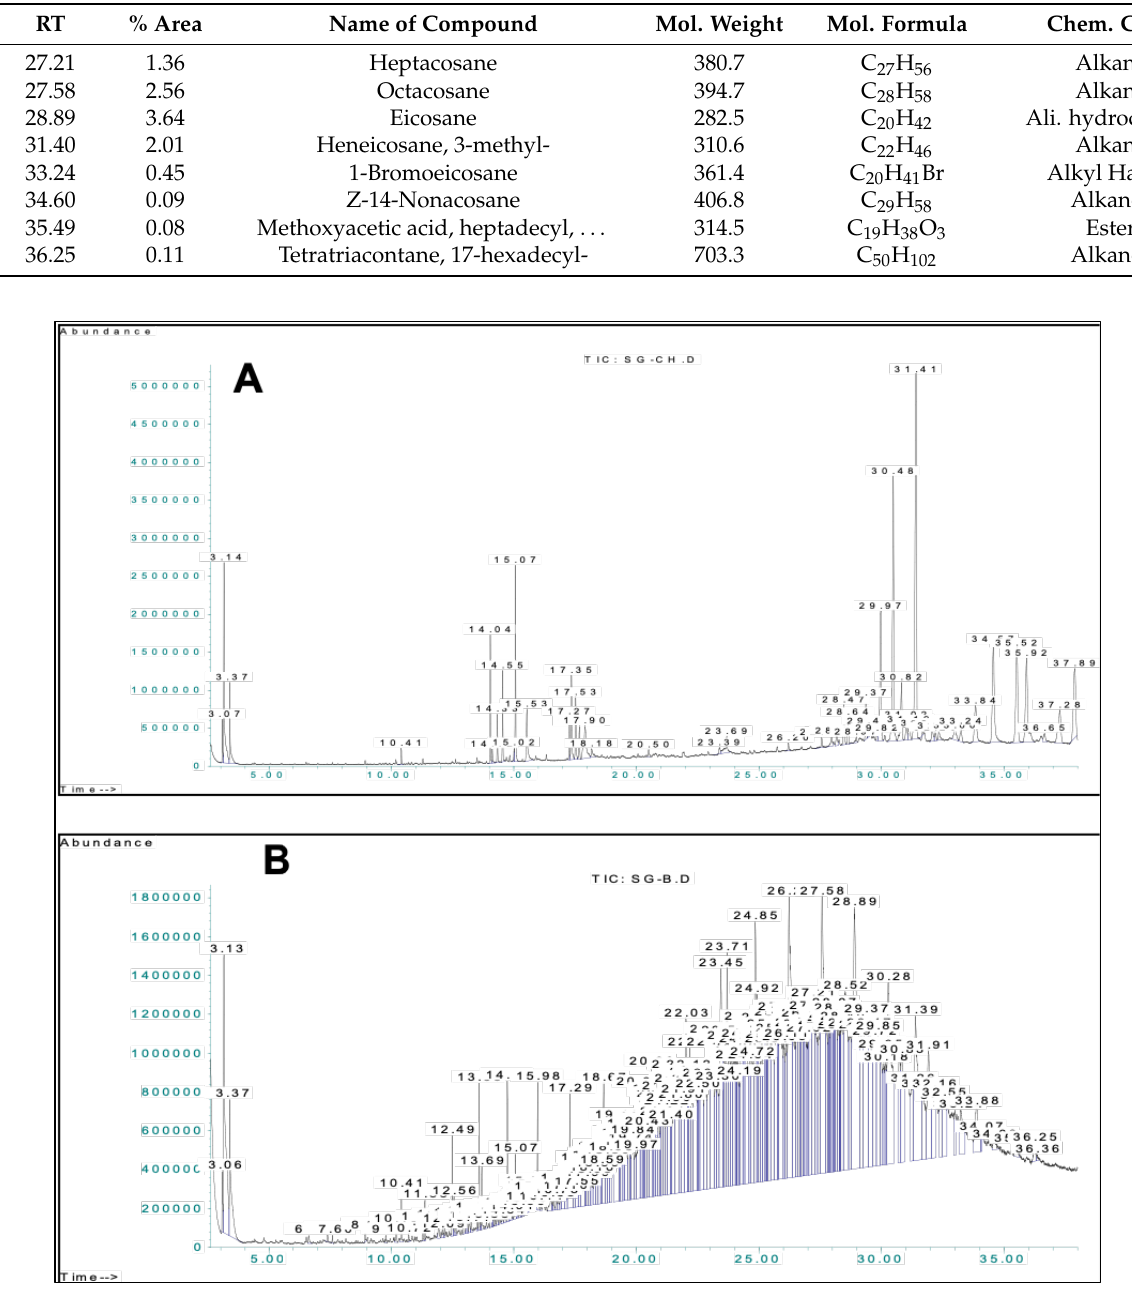
Figure 1. GC-MS chromatograms of chloroform ( A ) and n -butanol ( B ) fractions. Table 3. LC-ESI-MS-MS screening of Strobilanthes glutinosus in negative mode. To gain a more in-depth insight into the phytochemical composition through the LC-ESI-MS method, we looked into the phytochemicals present in the plant S. glutinosus in greater detail. Due to its many benefits, including low solvent consumption, high precision, and accuracy, the hybrid coupled technique is frequently employed for the investigation of phytochemicals derived from plants